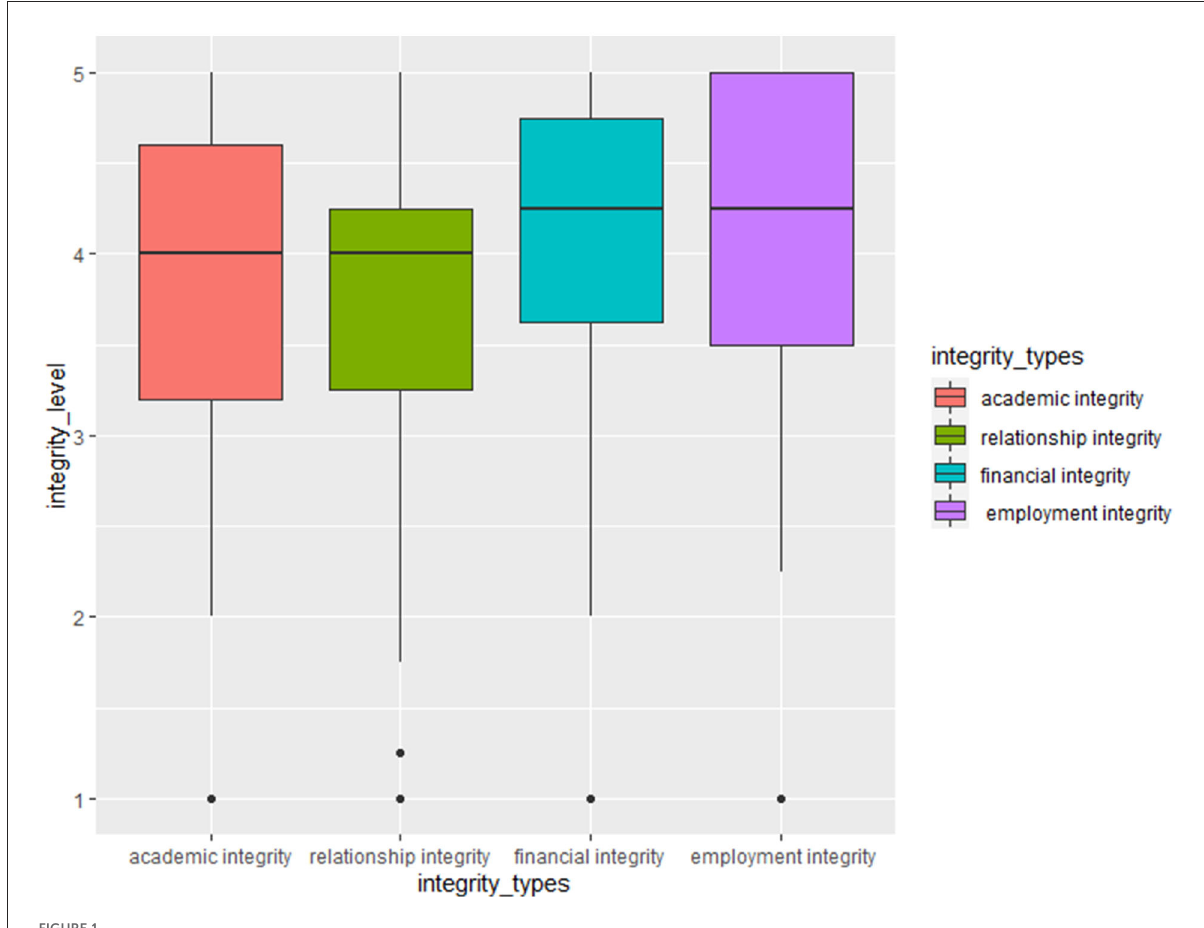
FIGURE1 Four Integrity levels of Chinese college